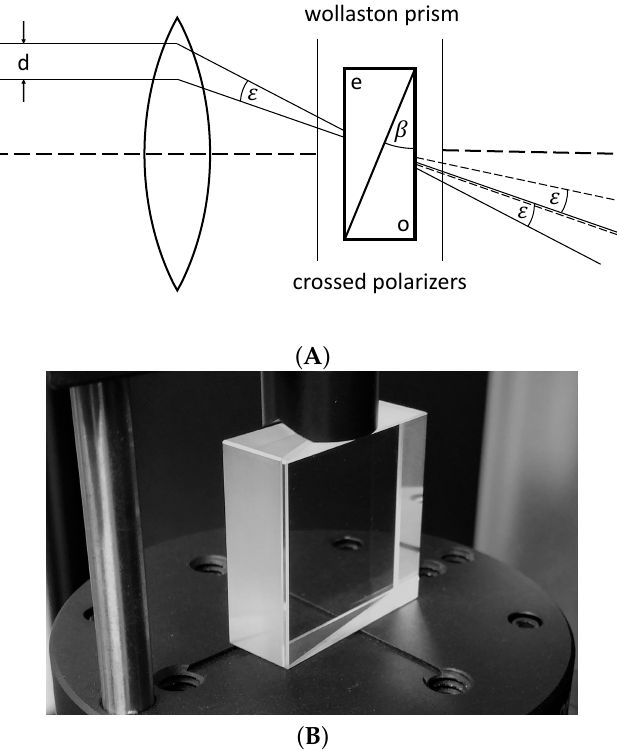
Figure 1. Working principle of the Wollaston prism ( A ) and used prism ( B ). ( A ) Two parallel rays separated by distance d before the lens are brought to interference after the prism; ( B ) Wollaston prism 30 × 30 × 5 mm, (cid:101) = 5.8 mrad, Societe d’Optique de Précision